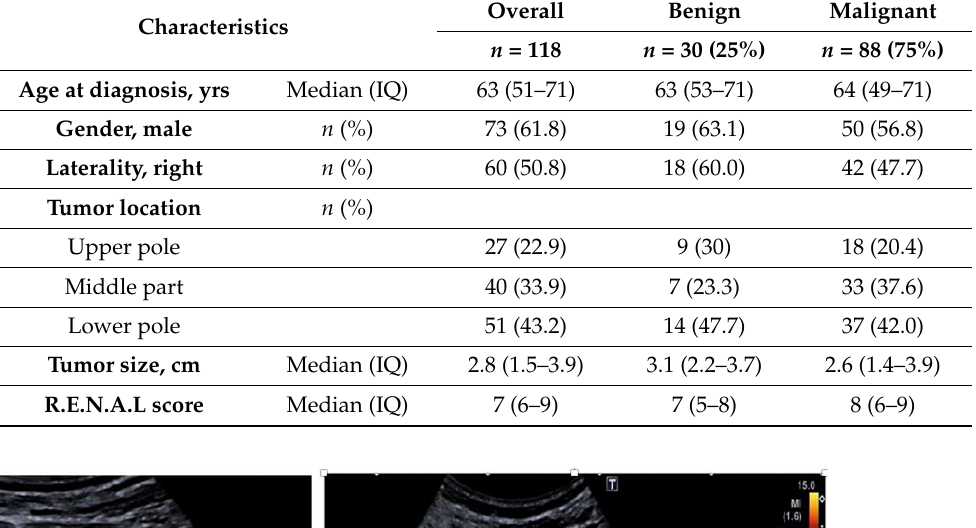
Table 1. Baseline data.